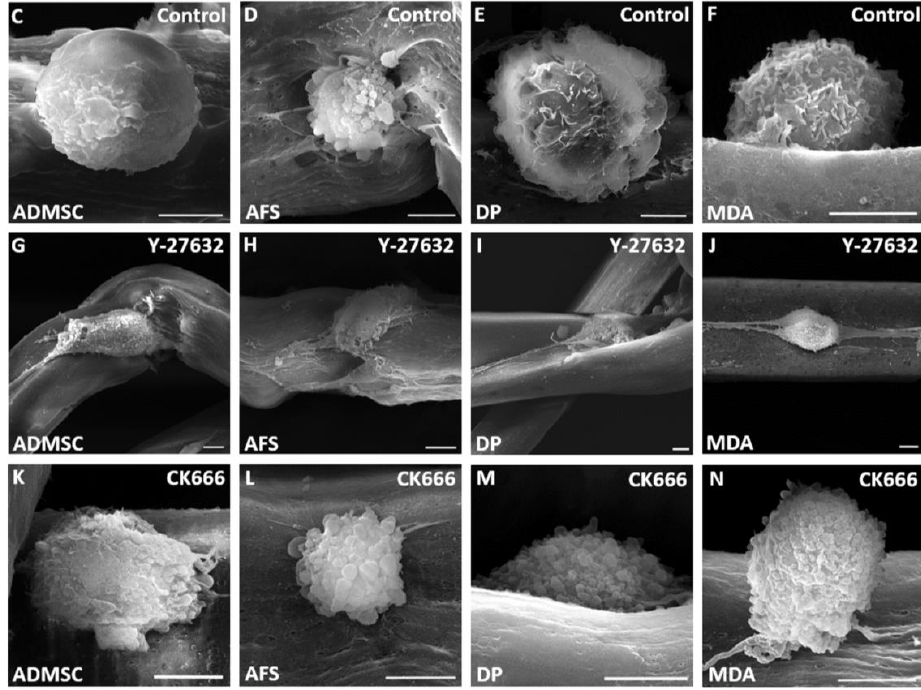
Figure 4. Influence of ROCK and Arp2/3 on cell surface characteristics of non-muscle cells on myofibres. ( A ) Quantification of bleb numbers on non-muscle cells following ROCK (Y-27632) and Arp2/3 (CK666) inhibition; ( B ) Bleb dimensions. Scanning electron microscopy (SEM) images of the